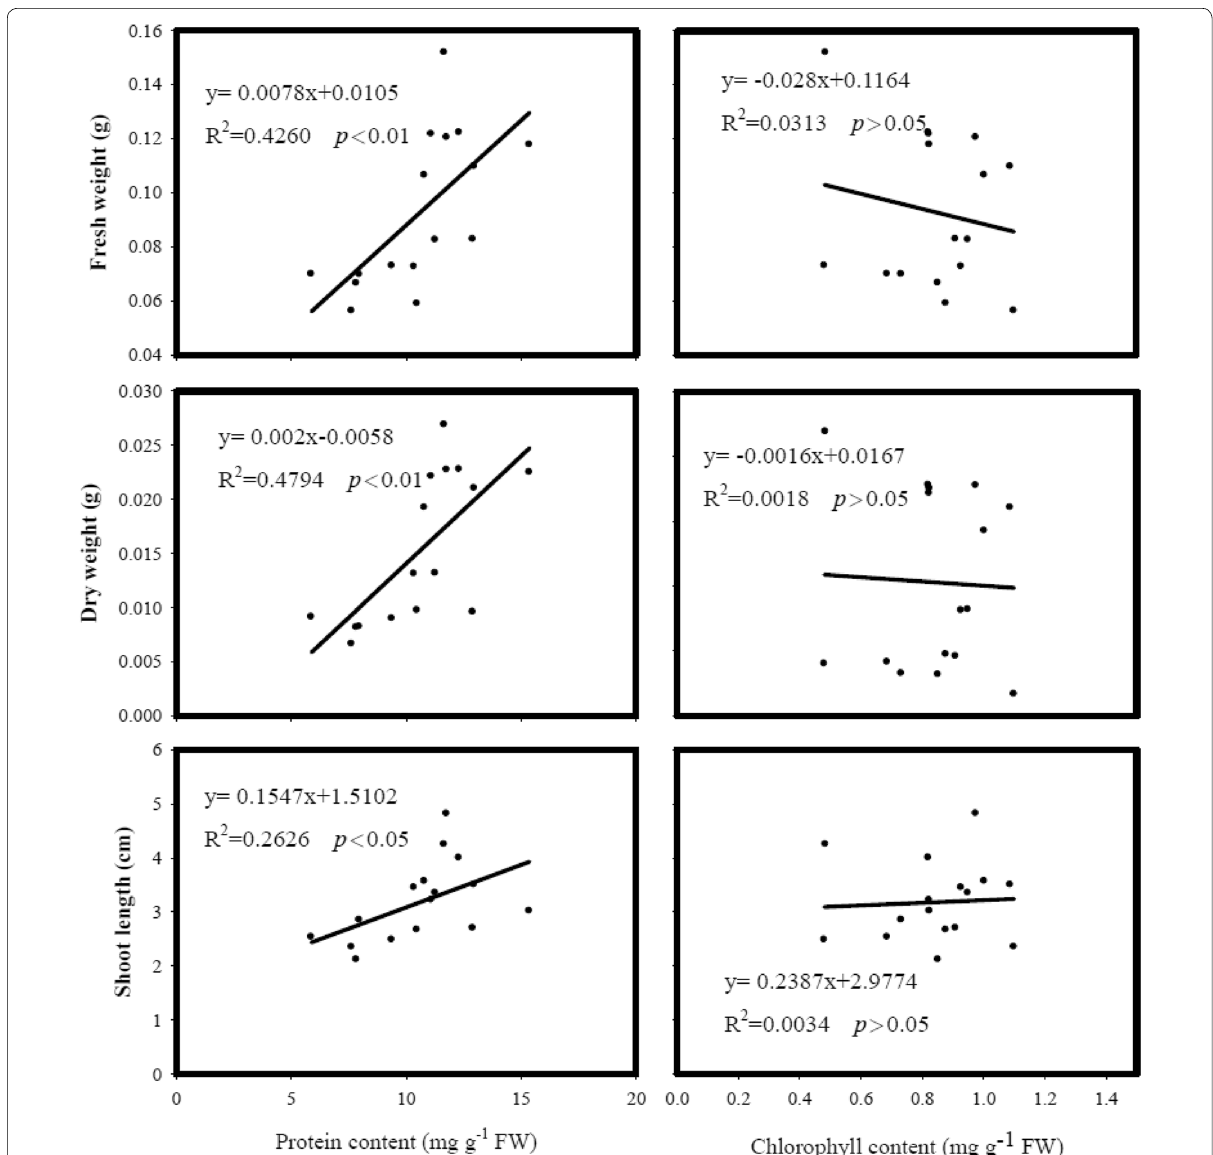
Fig. 2 The relationships of shoot protein contents and of chlorophyll contents with rice seedling fresh weight, dry weight and length under cold treatment among eight cultivars. The temperature was set at 15 °C for cold treatment and 27 °C for control. After 4 days of treatment, the temperature was adjusted to 27 °C for 3 days before